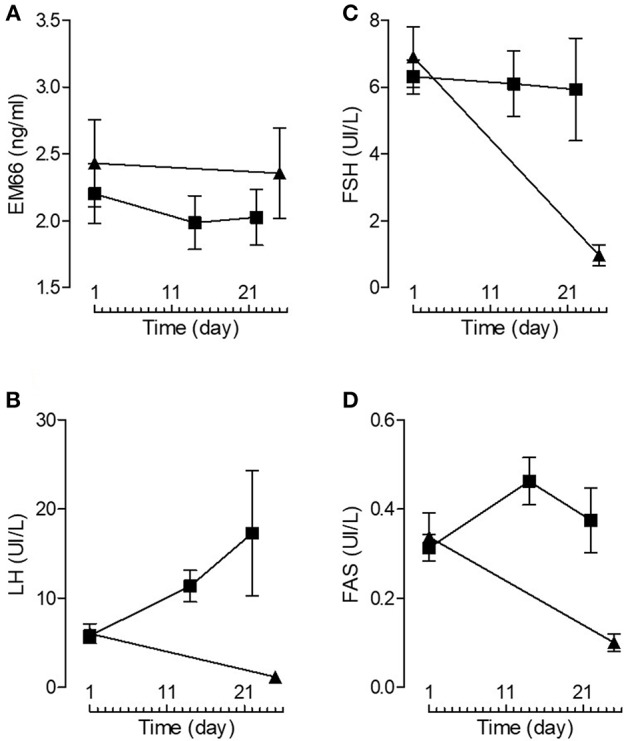
Plasma EM66 and gonadotropin levels of healthy women. Plasma EM66 (A), LH (B), FSH (C), and FAS (D) concentrations during the normal menstrual cycle (women without oral contraception, ■) and in women with oral contraception (▴). Values are means ± SEM (n = 8).